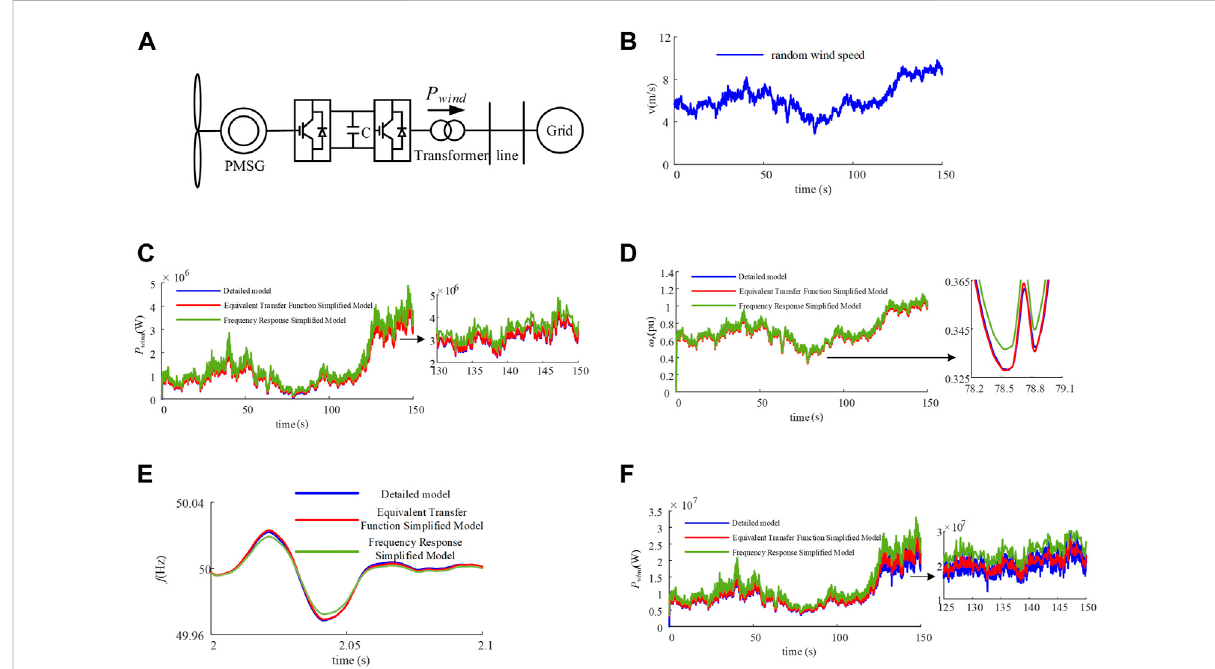
FIGURE 7 (A) Single-machine and multi-machine system simulation analysis shows the simulation structure diagram of a single wind turbine grid- connected system, on which the simulation analysis of the single system is carried out. (B) gives the simulated working conditions for the random wind speed. (C,D) Dynamic simulation analysis of a single wind turbine connected to the grid, and the simpli fi ed model of frequency response in other articles is selected to compare with the model in this paper, and the dynamic response characteristics are taken as the grid-connected power and rotor speed. (E) shows Comparison graph of system frequency under load fl uctuation, which veri fi es the effectiveness of the strategy in this paper under the dynamic characteristics of frequency. (F) Comparison graph of the output power of multiple wind turbines under the equivalence strategy of this paper, which veri fi es the consistent effectiveness of the equivalence method of this paper for the output power.